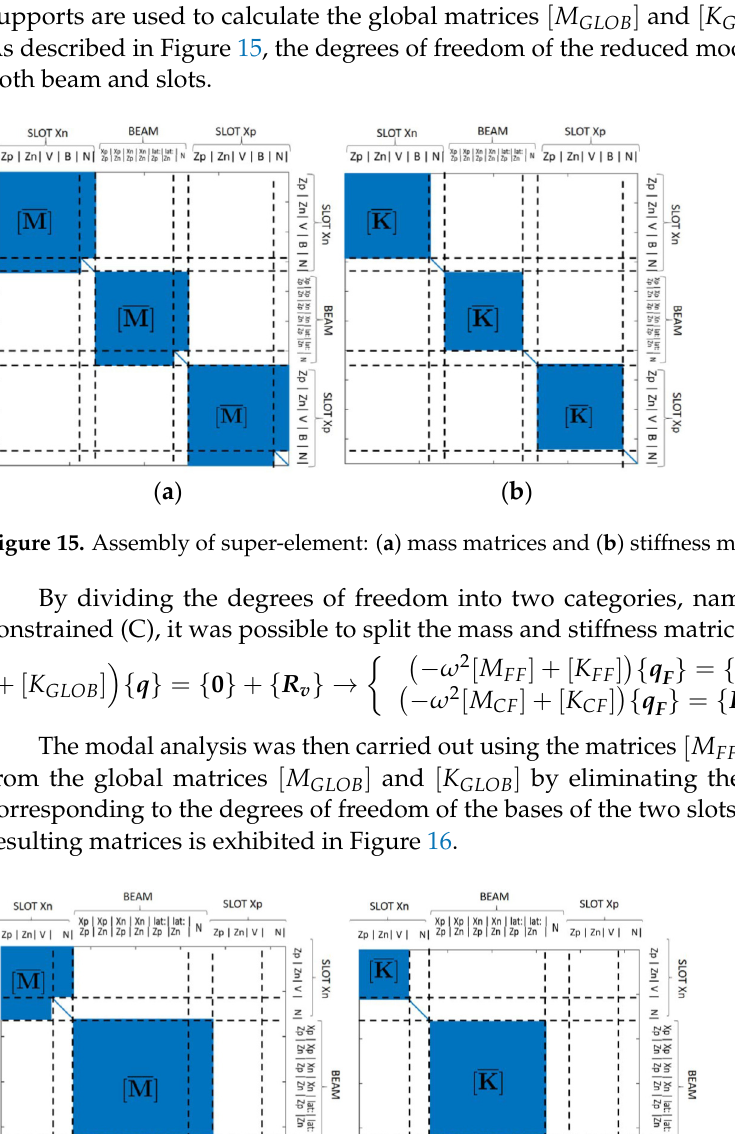
Figure 14. Master nodes for reduced model: ( a ) support and ( b ) beam.